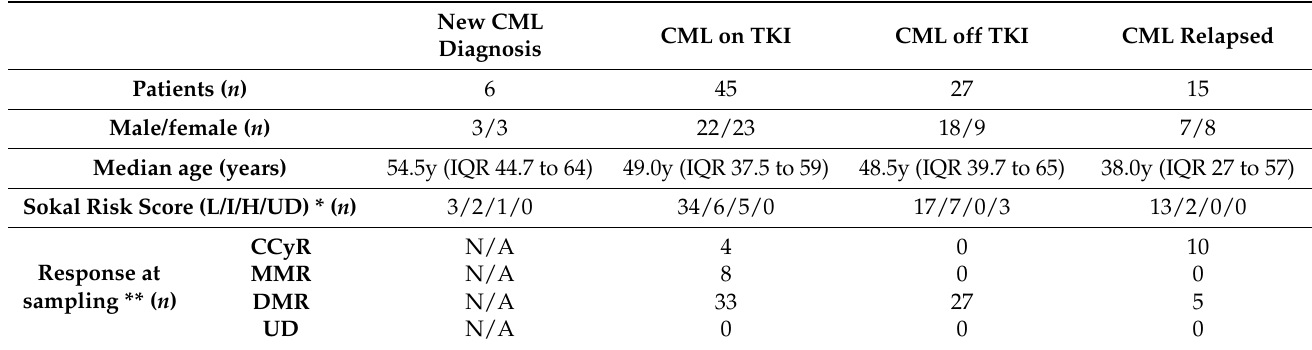
Table 1. Summary of clinical data of patients with chronic myeloid leukemia (CML) that participated in the study. New CML CML on TKI CML off Diagnosis